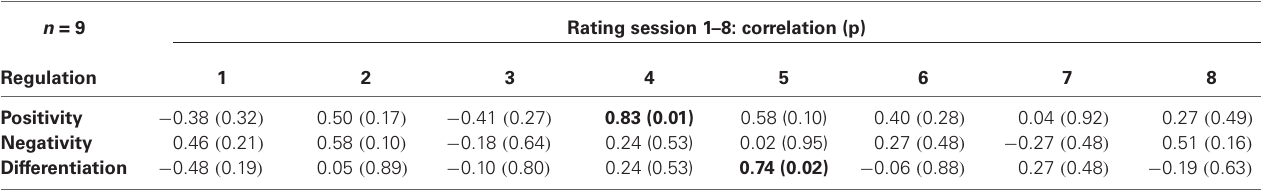
Pearson correlation coefficients for the SCP group between regulation performance (positivity, negativity, and differentiation = positivity − negativity) and the subjective ratings of the participants guessing the group assignment (SCP vs. placebo condition).